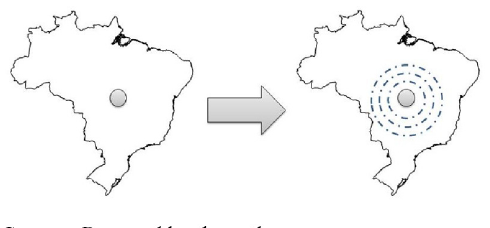
Figure 1. Representation of scaling up